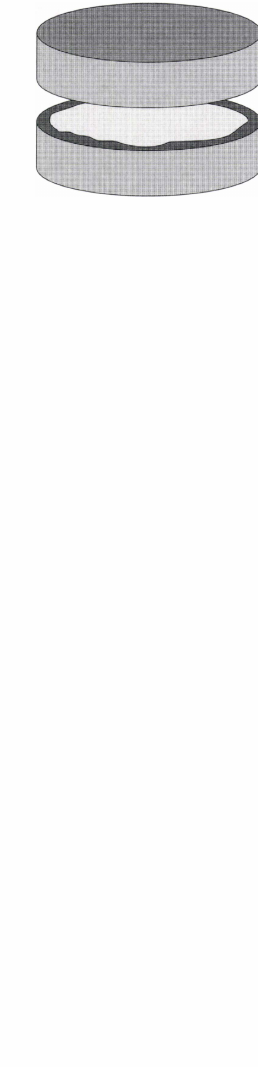
Tabel/e 1: Parameter der Oswald-de Waele· und Herschei-Bulkley-Model/e industrieller Mahlpasten 1 und 2 sowie deren drei Mi· schungen Table 1: Parameters of the Ostwald·de Waele and Herschei-Bulkley models for industrial mill bases 1 and 2 and three mictures